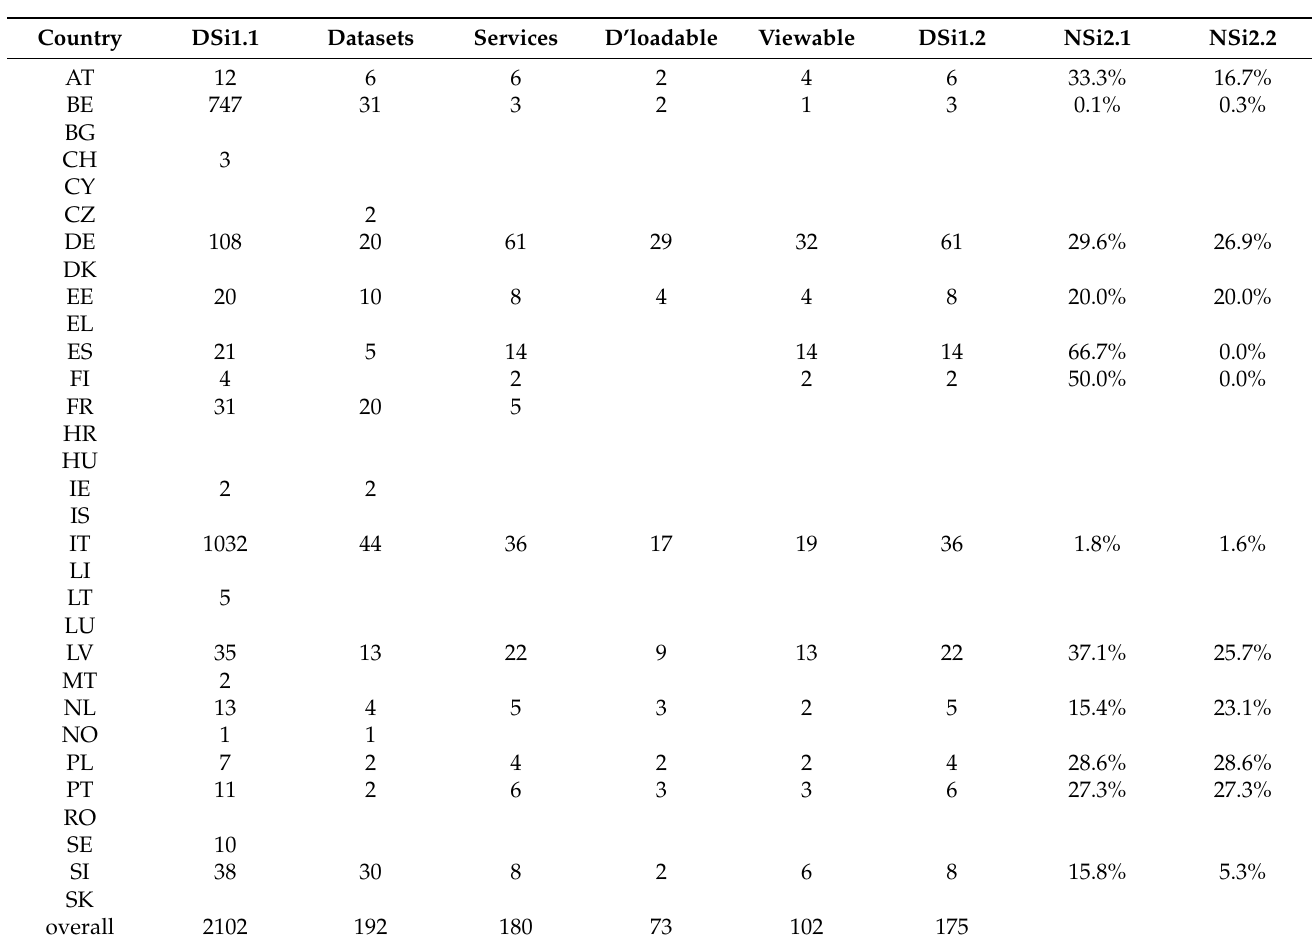
Table 2. Indicators of availability for hydrogeology.